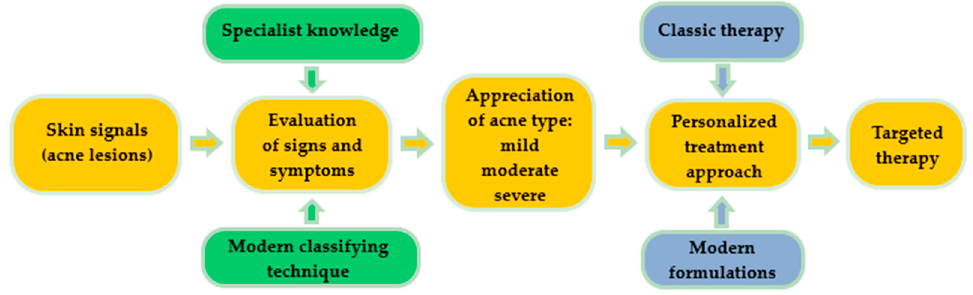
Figure 1. Schematic representation concerning the impact of a right diagnosis for a personalized treatment in a dermatologic disease.